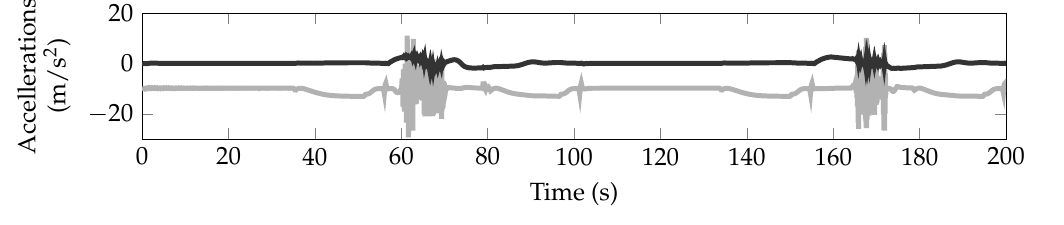
Figure 13. Simulated vertical ( ) and horizontal ( ) accelerations on the left wing